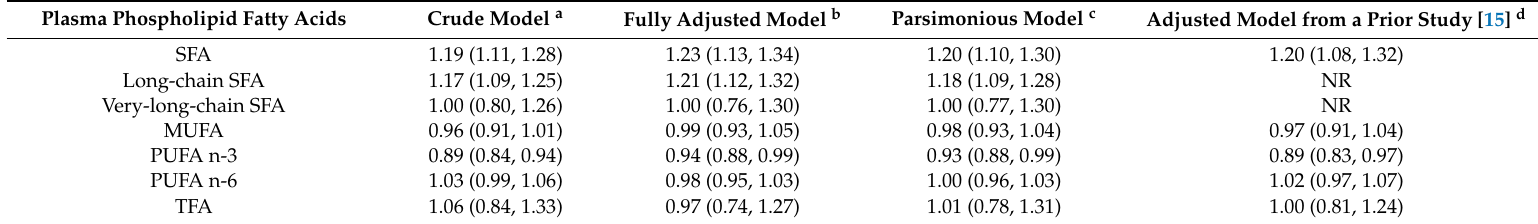
Table A2. Associations between plasma phospholipid fatty acids (1 moL %) and CHD risk adjusting for different confounders in the matched case-control study ( N = 2428).